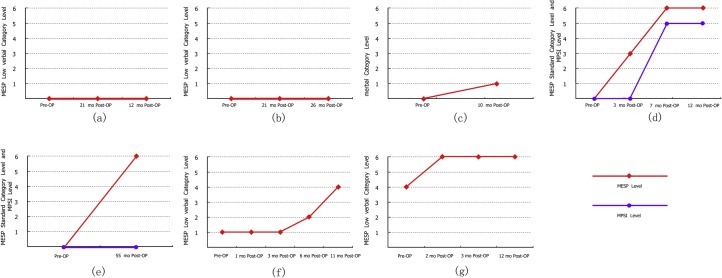
Progress according to MESP performance.(a) ANCI_01, MESP performance; (b) ANCI_02, MESP performance; (c) ANCI_03, MESP performance; (d) ANCI_04, MESP and Mandarin Pediatric Speech Intelligibility Test performance; (e) ANCI_05, MESP performance; (f) ANCI_09, MESP performance; (g) ANCI_10, MESP performance. MESP, Mandarin Early Speech Perception Test.